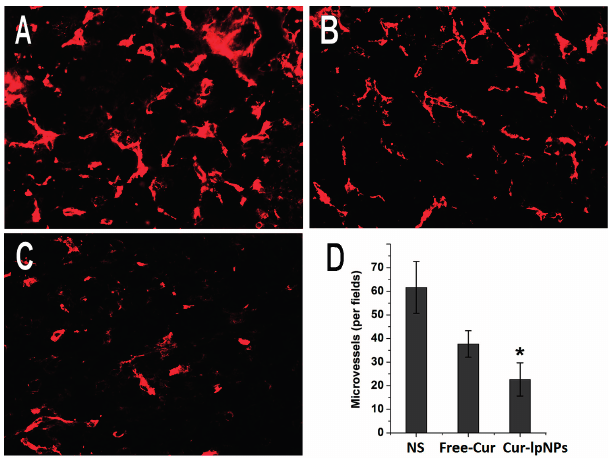
Figure 8. CD31 immunofluorescent staining of tumors in each group. Representative CD31 immunofluorescent images (magnification: 40×) of NS ( A ); free Cur ( B ); and Cur–lpNPs ( C ) group; and mean microvessel density (MVD) in each group ( D ) ( * p <